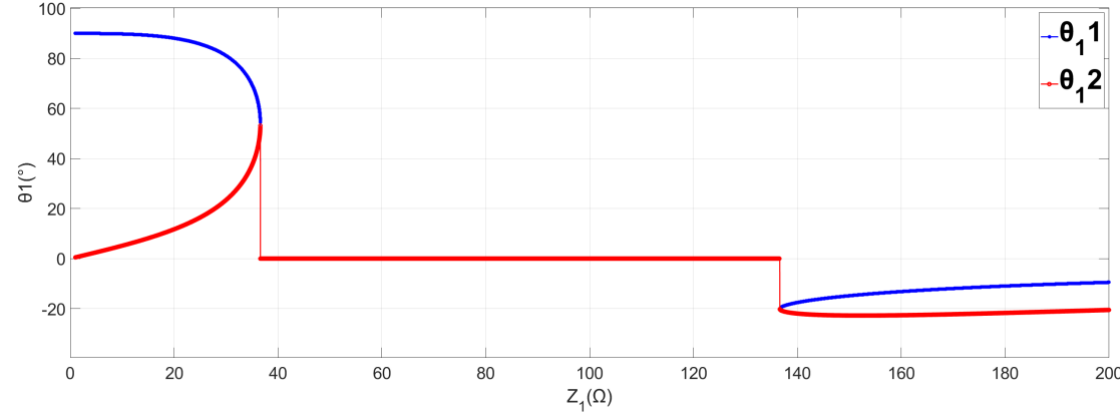
◦ Ω and θ b to 30